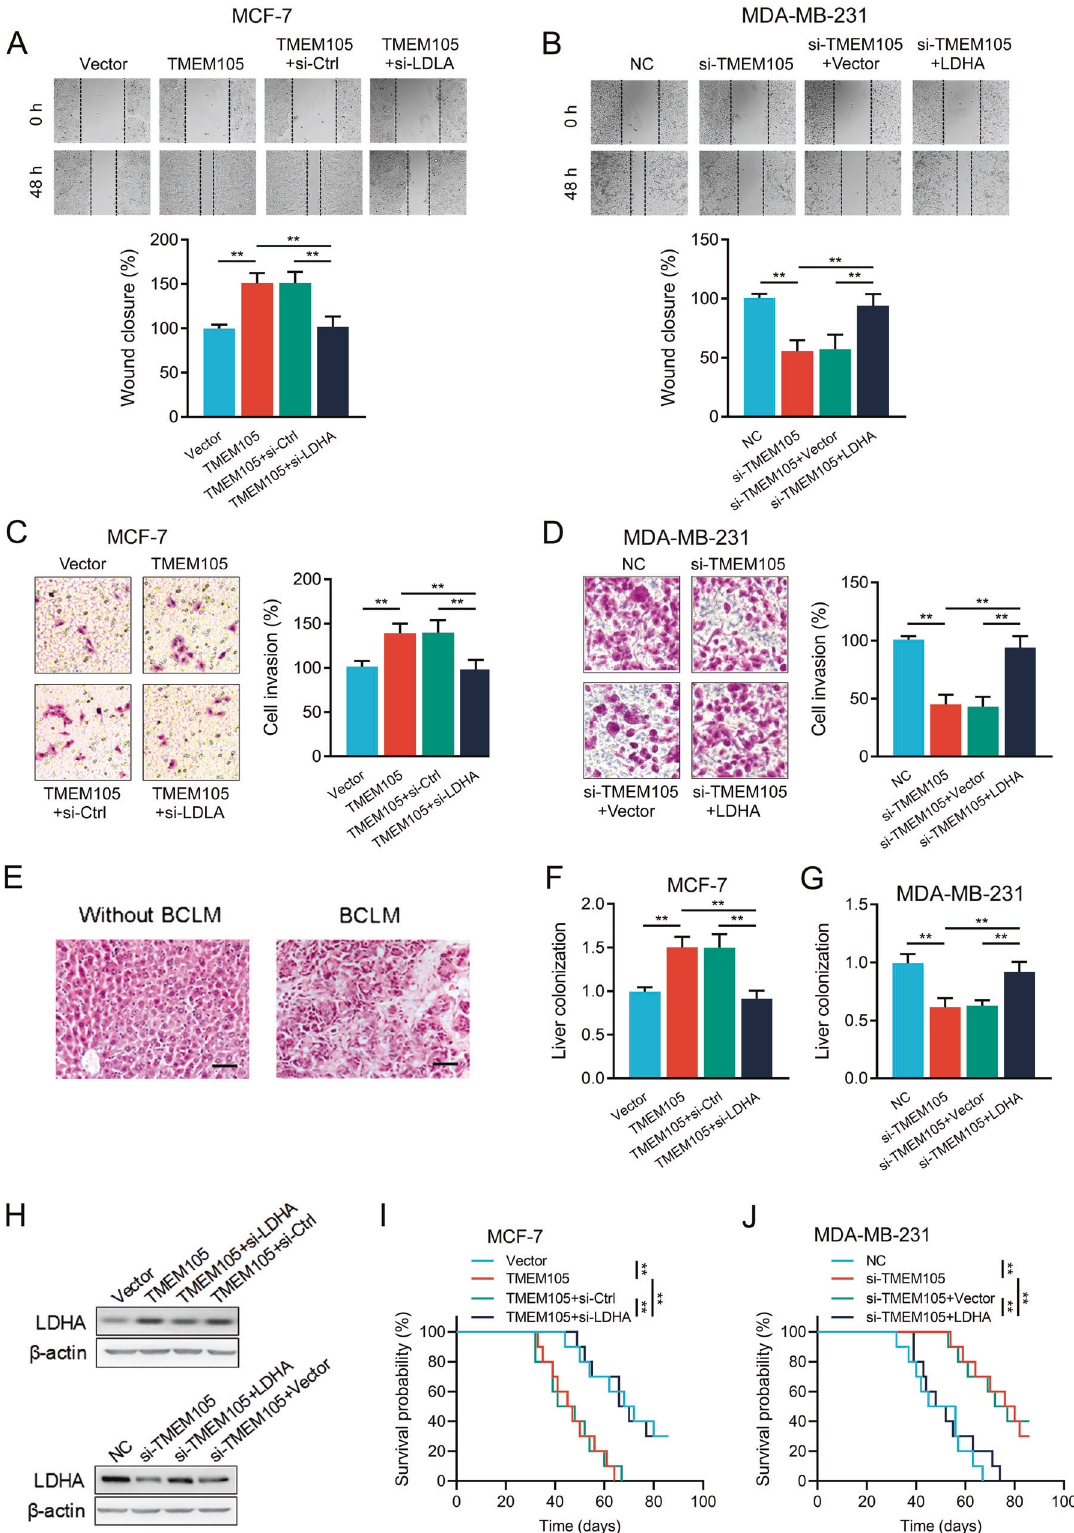
Fig. 4 TMEM105 enhances breast cancer cell invasion and liver metastasis via promoting LDHA expression. Wound healing assay was performed to detect the effects of LDHA knockdown or overexpression on the migration of TMEM105-overexpressing MCF-7 cells ( A ) and TMEM105-knockdown MDA-MB-231 cells ( B ). Transwell matrigel assay was performed to detect the effects of LDHA knockdown or overexpression on the invasion of TMEM105-overexpressing MCF-7 cells ( C ) and TMEM105-knockdown MDA-MB-231 cells ( D ). E Representative HE images of the livers from nude mice without or with BCLM. Scale bar, 50 μ m. F , G The BCLM in the mice was determined by qRT-PCR assays. H Western blot analysis of LDHA expression in liver metastatic lesions from nude mice injected with engineered breast cancer cells. I , J Changes of the overall survival in nude mice injected with engineered MCF-7 ( I ) and MDA-MB-231 ( J ) cells ( n = 8 for each group). ** p <